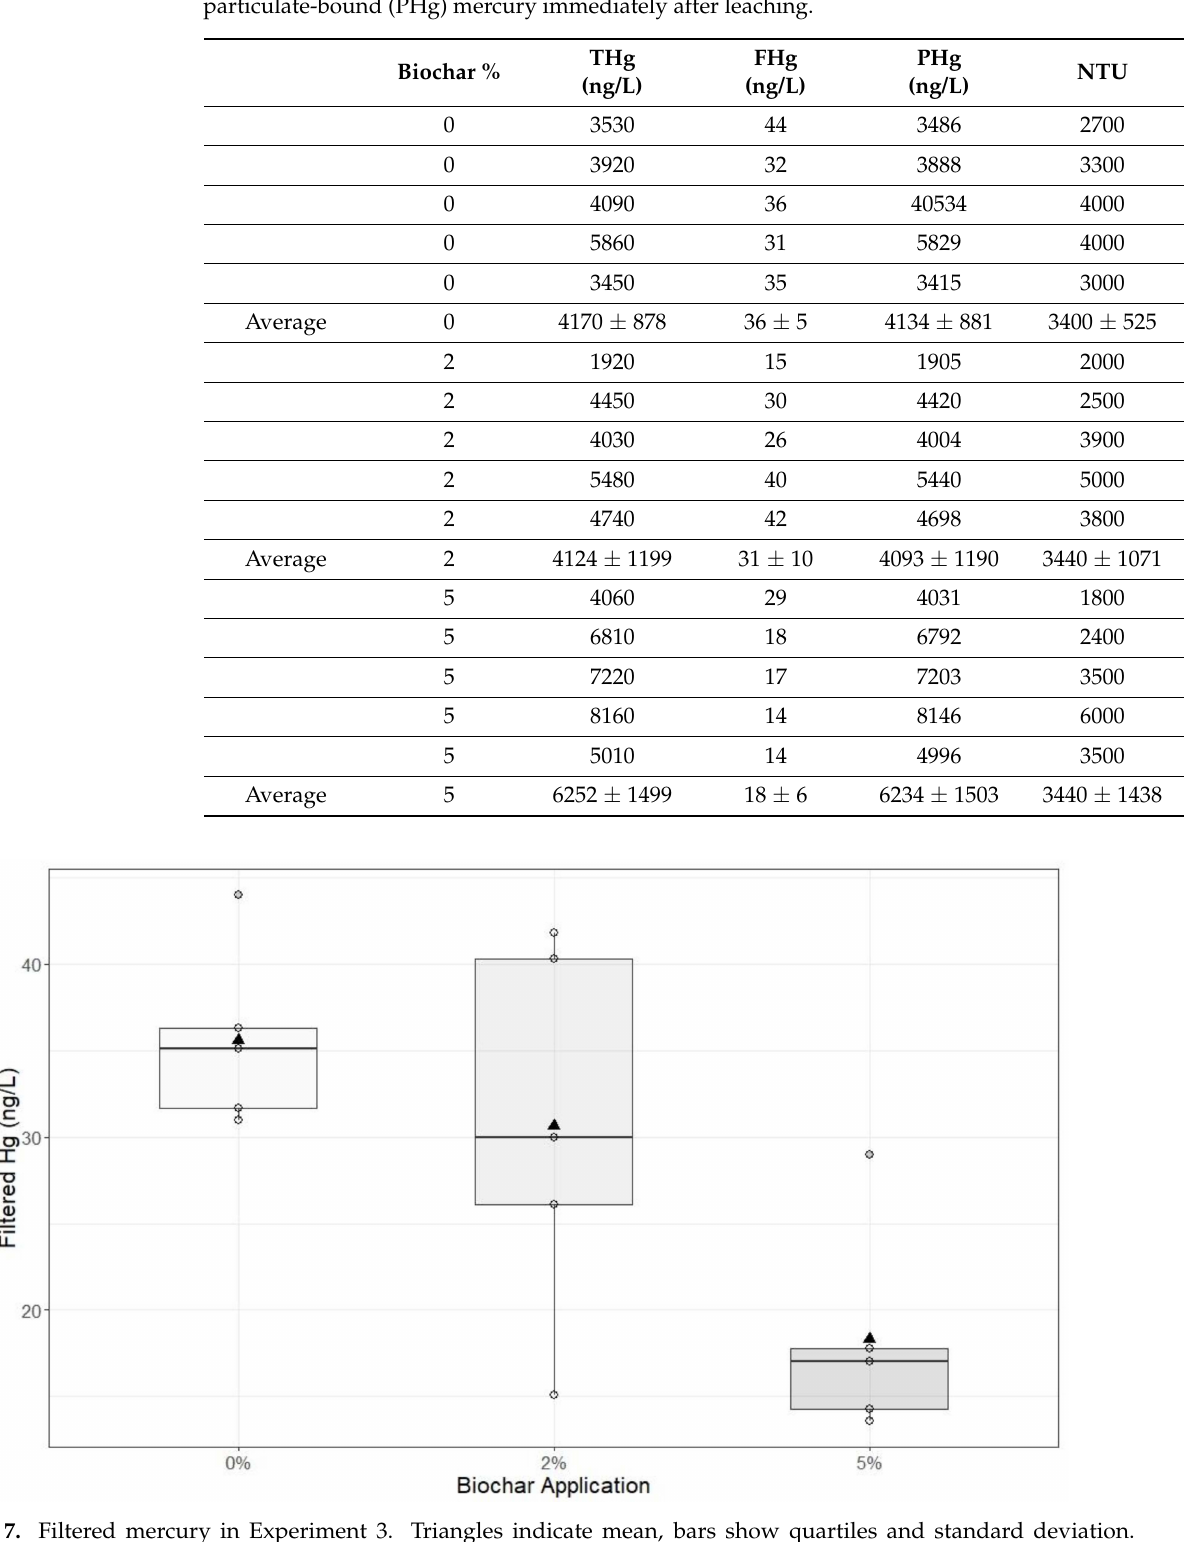
Figure 7. Filtered mercury in Experiment 3. Triangles indicate mean, bars show quartiles and standard deviation. The 5% biochar significantly decreased filtered Hg in the outflow immediately after leaching ( p = 0.001, n =